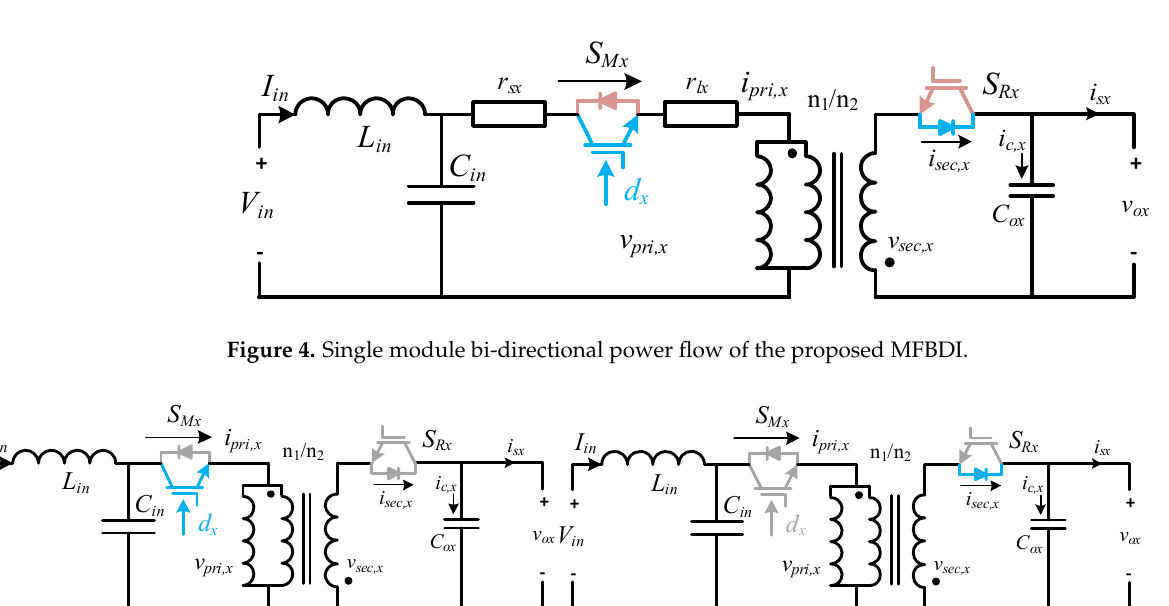
Figure 5. Temporarily power transfer of the MFBDI: ( a ) Energy storage in the HFT magnetizing inductance, ( b ) Energy release to supply the load and charging the output capacitor. The input DC-voltage/PV voltage is assumed to be constant due to LC filter’s large capacitance at the input side. The proposed MFBDI is controlled via continuous conduction-mode (CCM), in which the transformer core incompletely demagnetizes in one switching cycle. The demagnetizing effect of the MFBDI transformer has a negligible